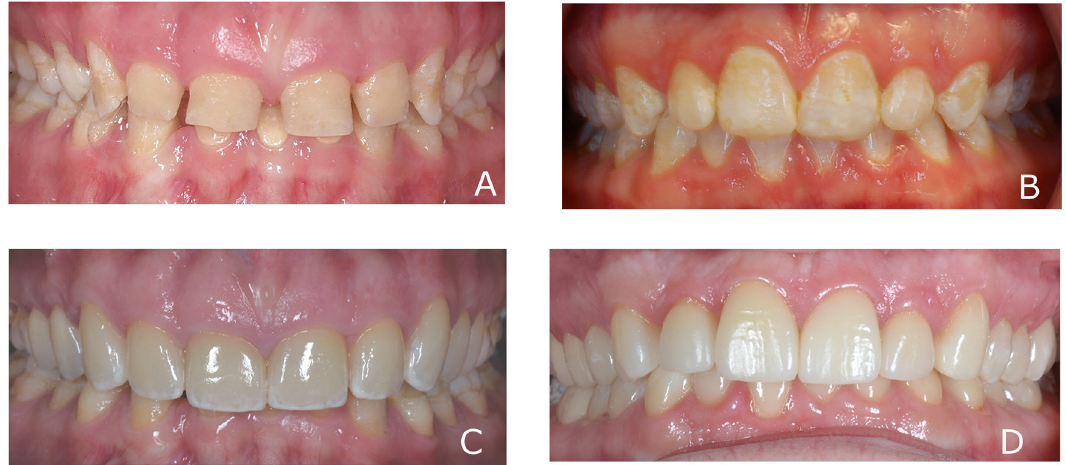
Fig 1. Clinical appearance before and after ceramic crown therapy. A) Hypoplastic type of AI before start of therapy, C) After crown therapy at 14 years of age, B) Hypomineralized form of AI before start of therapy, D). After crown therapy at 17 years of